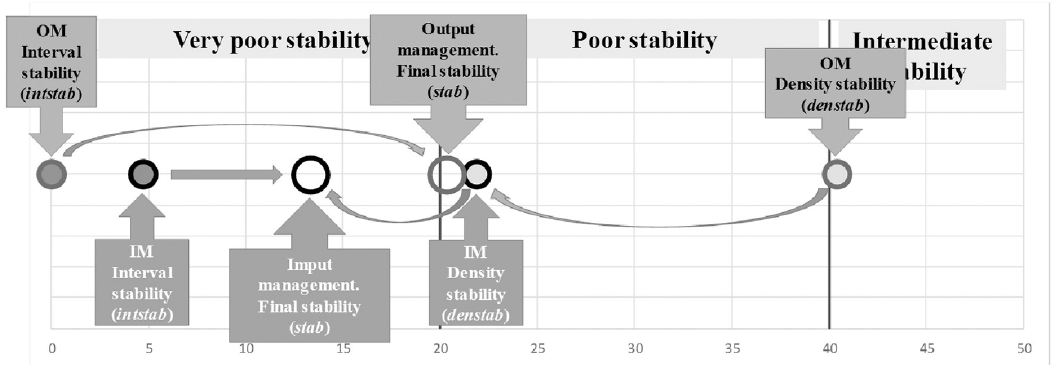
Fig 5. Global stability of the system: Initial situation (stab = 0.5 × intstab + 0.5 × denstab)